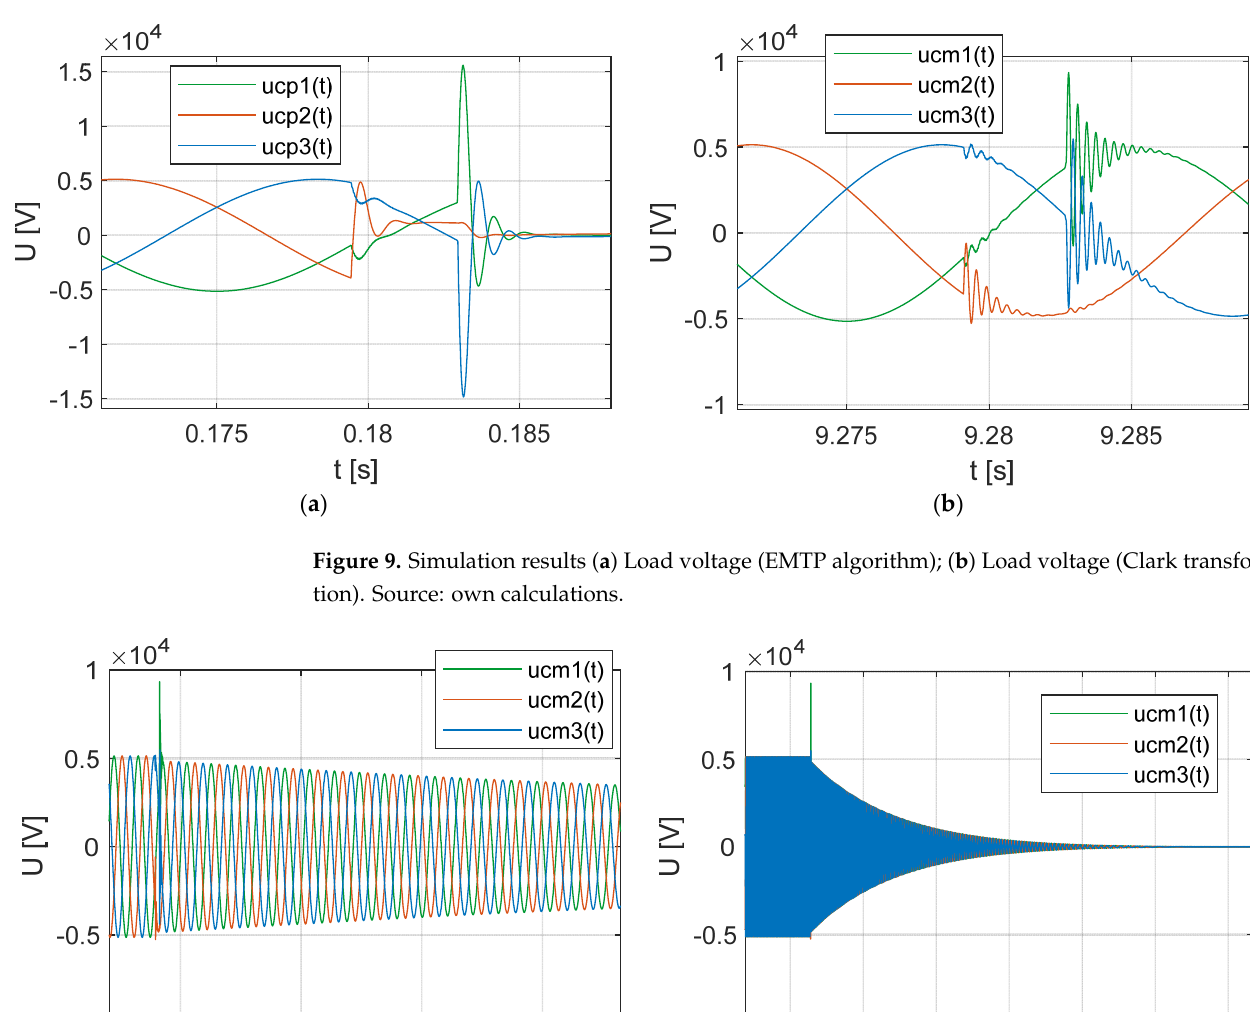
14 of 22 Table 2. Vacuum circuit breaker parameters. Parameter